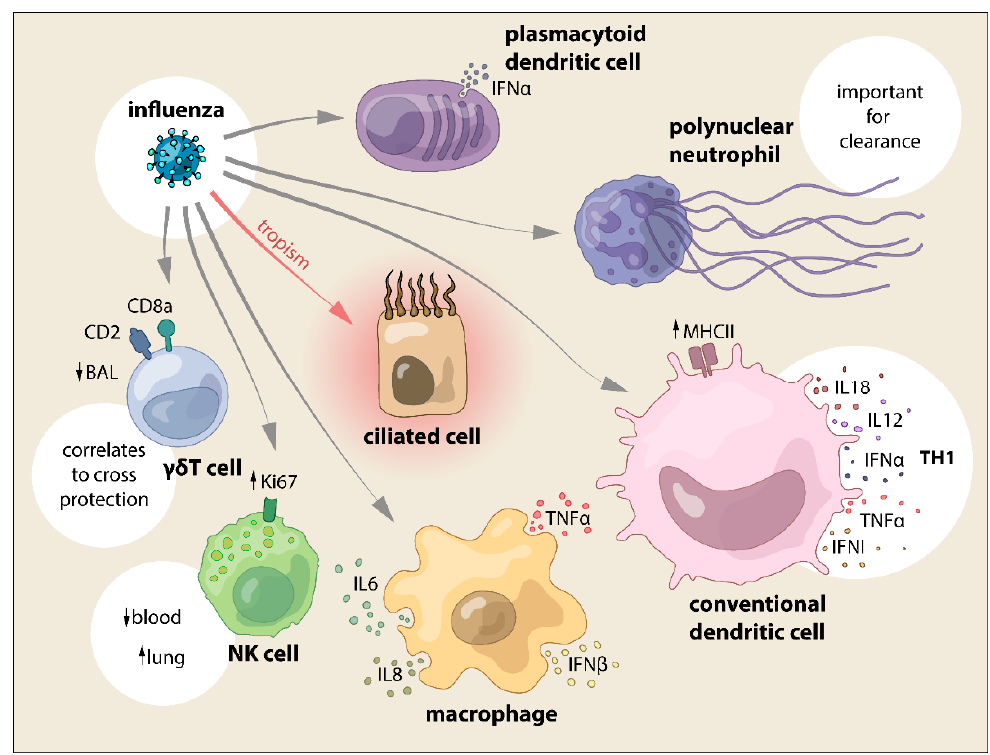
Figure 3. SwIV interaction with cells from the innate immune system and the main effects